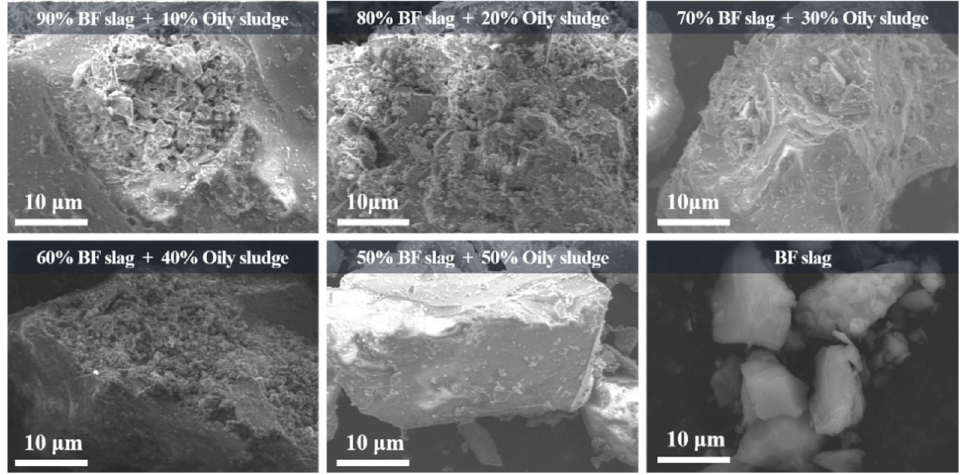
Figure 6. SEM microscopic image of the slag after pyrolysis (BFS-P).